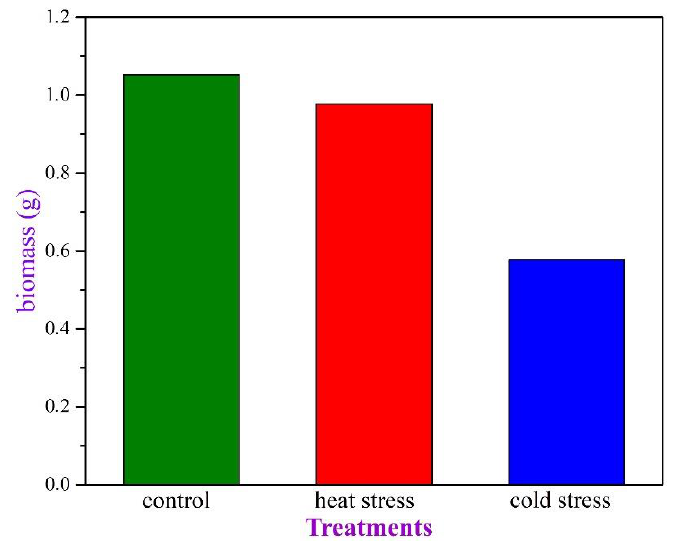
Figure 2. The cumulative biomass — both the above ground parts and the root — for all three groups of plants.